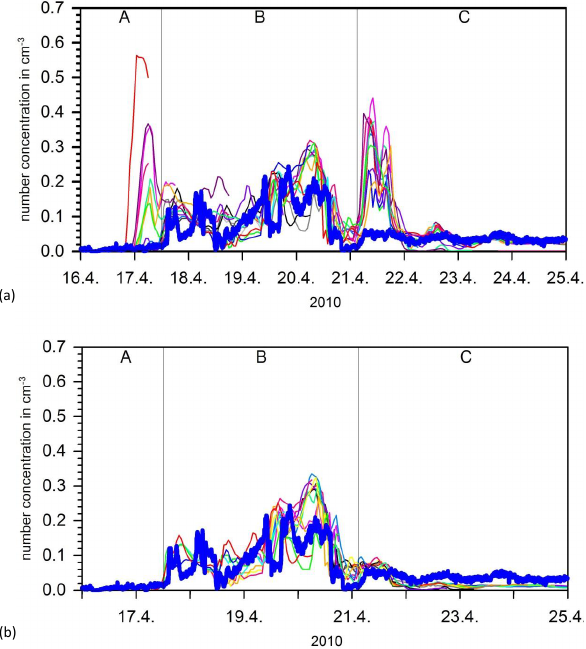
Figure 6. Temporal development of the simulated (thin) and ob- served (thick) number density of the 3µm particles. (a) relation between source height and source strength following Mastin et al. (2009) and (b) correction of the source strength according to Stohl et al. (2011). The thin lines give the results of the forecast runs that are started with a time lag of 6h.